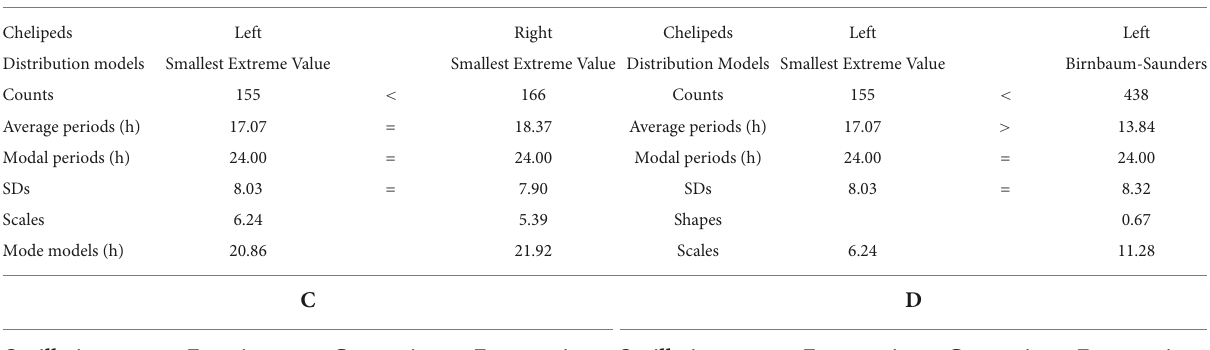
TABLE 2 Models and parameters of the records presented in Figure 2 . A B Oscillation states Entrainment Comparison Entrainment Oscillation states Entrainment Comparison Freerunning Chelipeds Left Right Chelipeds